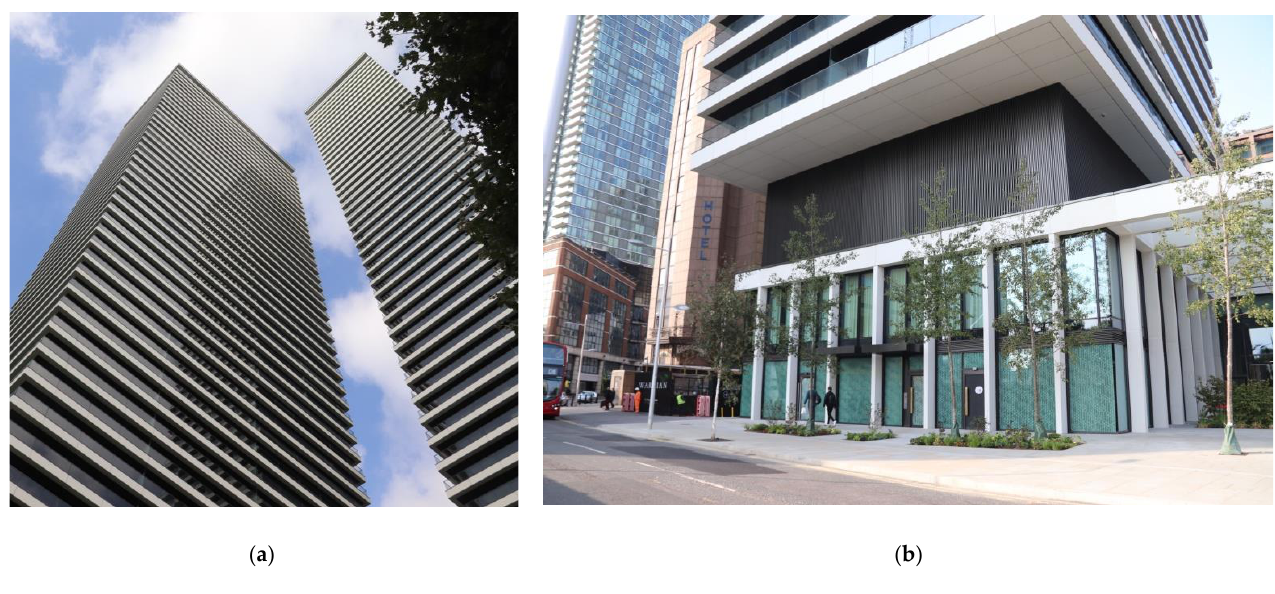
Figure 12. Colour applied to create formal illusions, the Wardian. ( a ) Regular rhythm of elevations with depth of balconies amplified by dark colour soffits (2020); ( b ) The entrance area visually disjointed from the main mass of the building through the dark colour louvers wrapping the service level (2020).